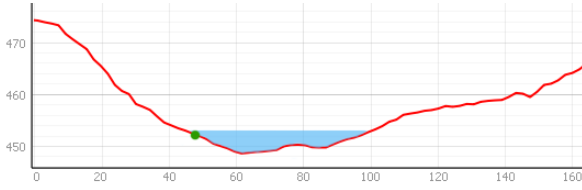
Figure 13 . Terrain section at the entrance of the hypogeum (green point). Units: